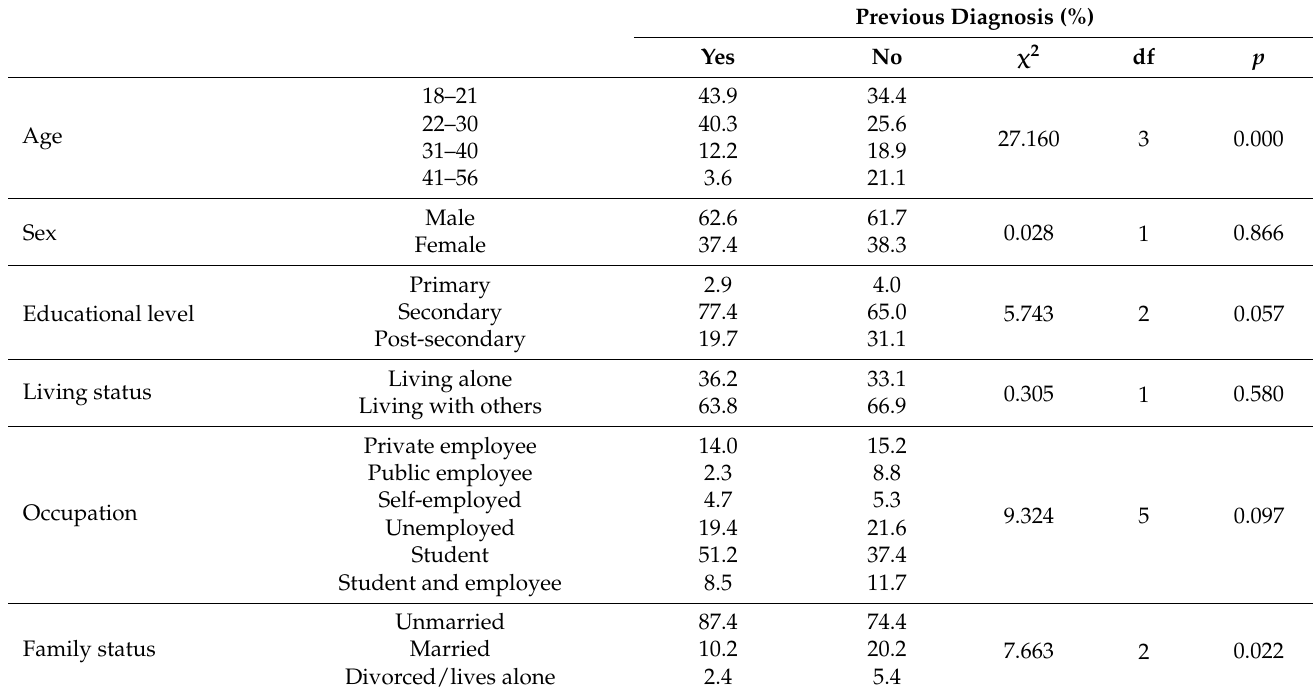
Table A6. Relationship of the Previous diagnosis of the assessed adults with the other